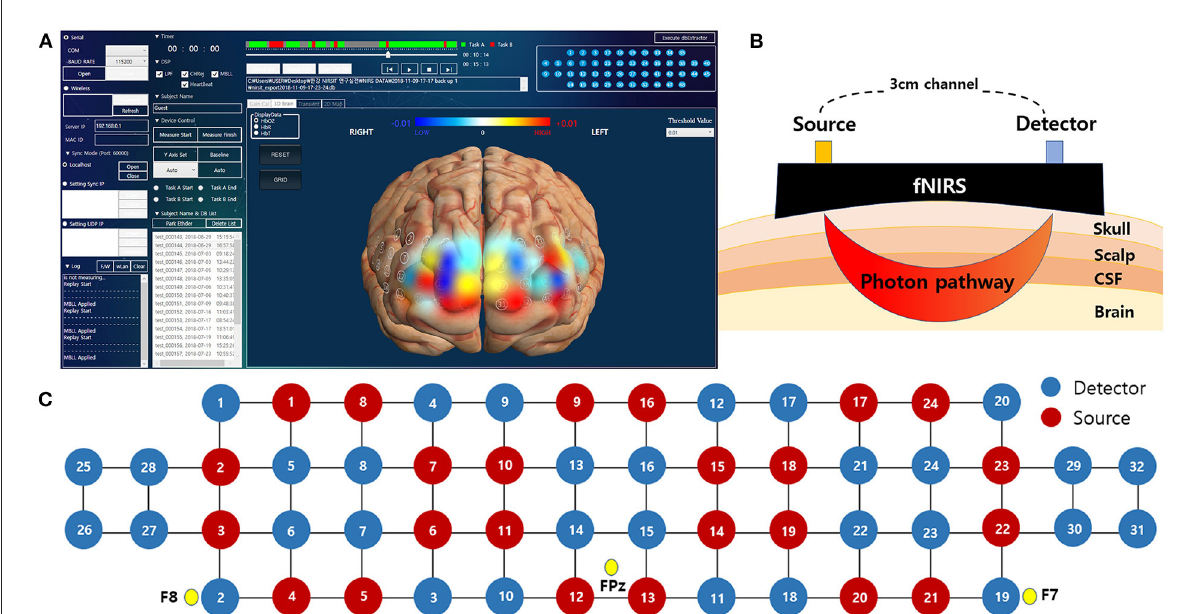
FIGURE3 The fNIRS system used in this study. (A) An actual analysis program in which the measured data directly visualize the change in hemoglobin level as a color map on a 3-dimensional image. (B) Schematic diagram of fNIRS channels with different source-detector distance. (C) Spatial profiles of fNIRS channels with 10-20 system reference position. fNIRS, functional near-infrared spectroscopy.